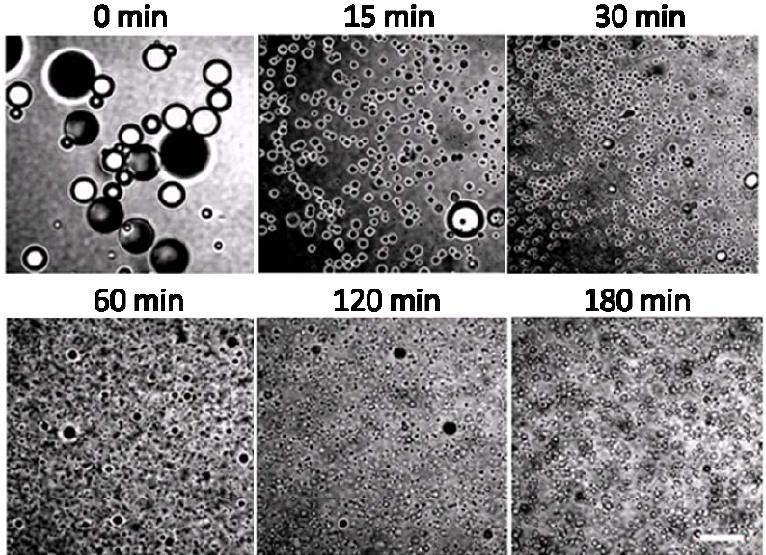
Figure 7. Representative transmitted light images viewed on a confocal microscope of the polymerization system sampled at different time intervals after initiation. The scale bar represents 20